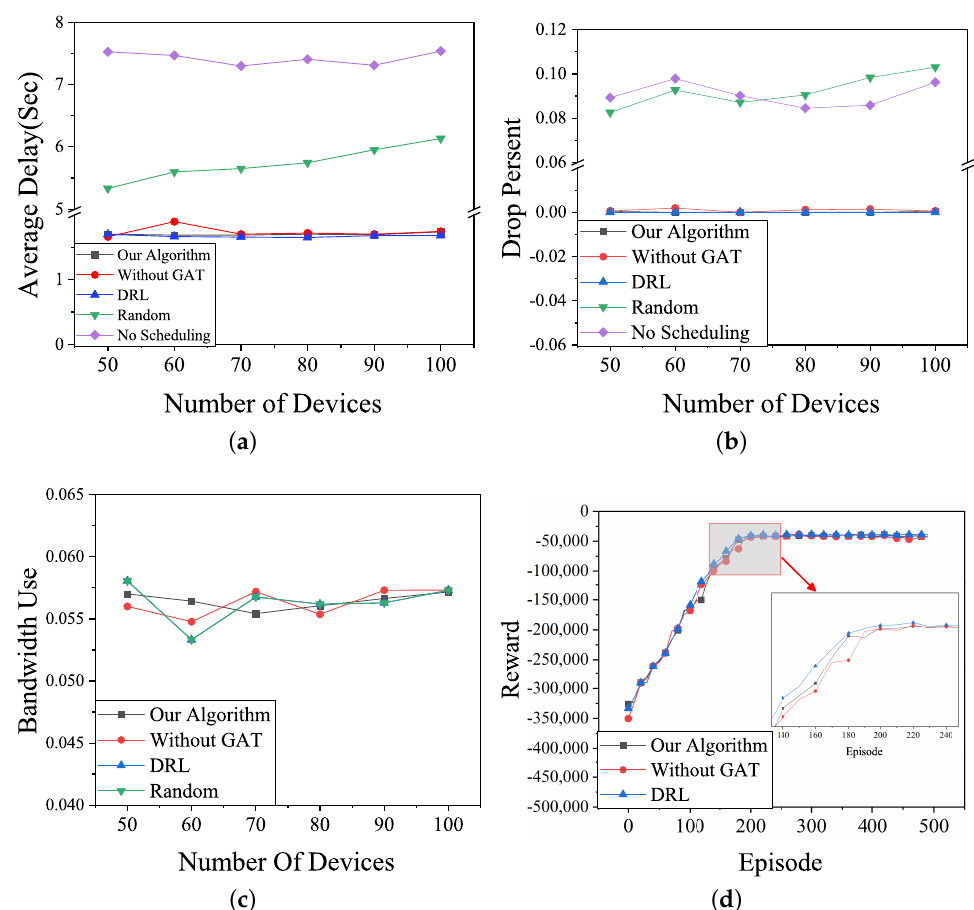
Figure 6. One-task scheduling simulation results obtained over 500 episodes. ( a ) Delay; ( b ) Drop; ( c ) Bandwidth; ( d )